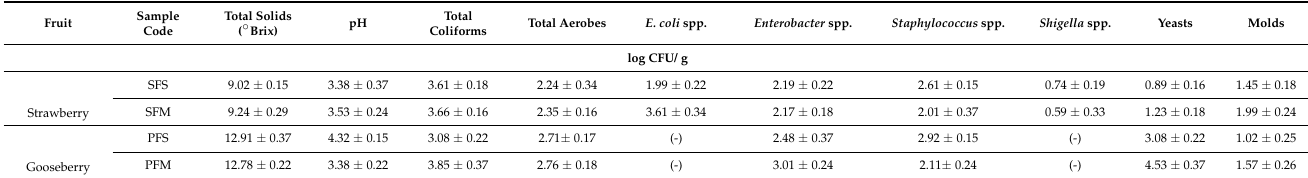
Table 1. Physicochemical characteristics and prevalence of microbial indicators in fresh strawberries and gooseberries.